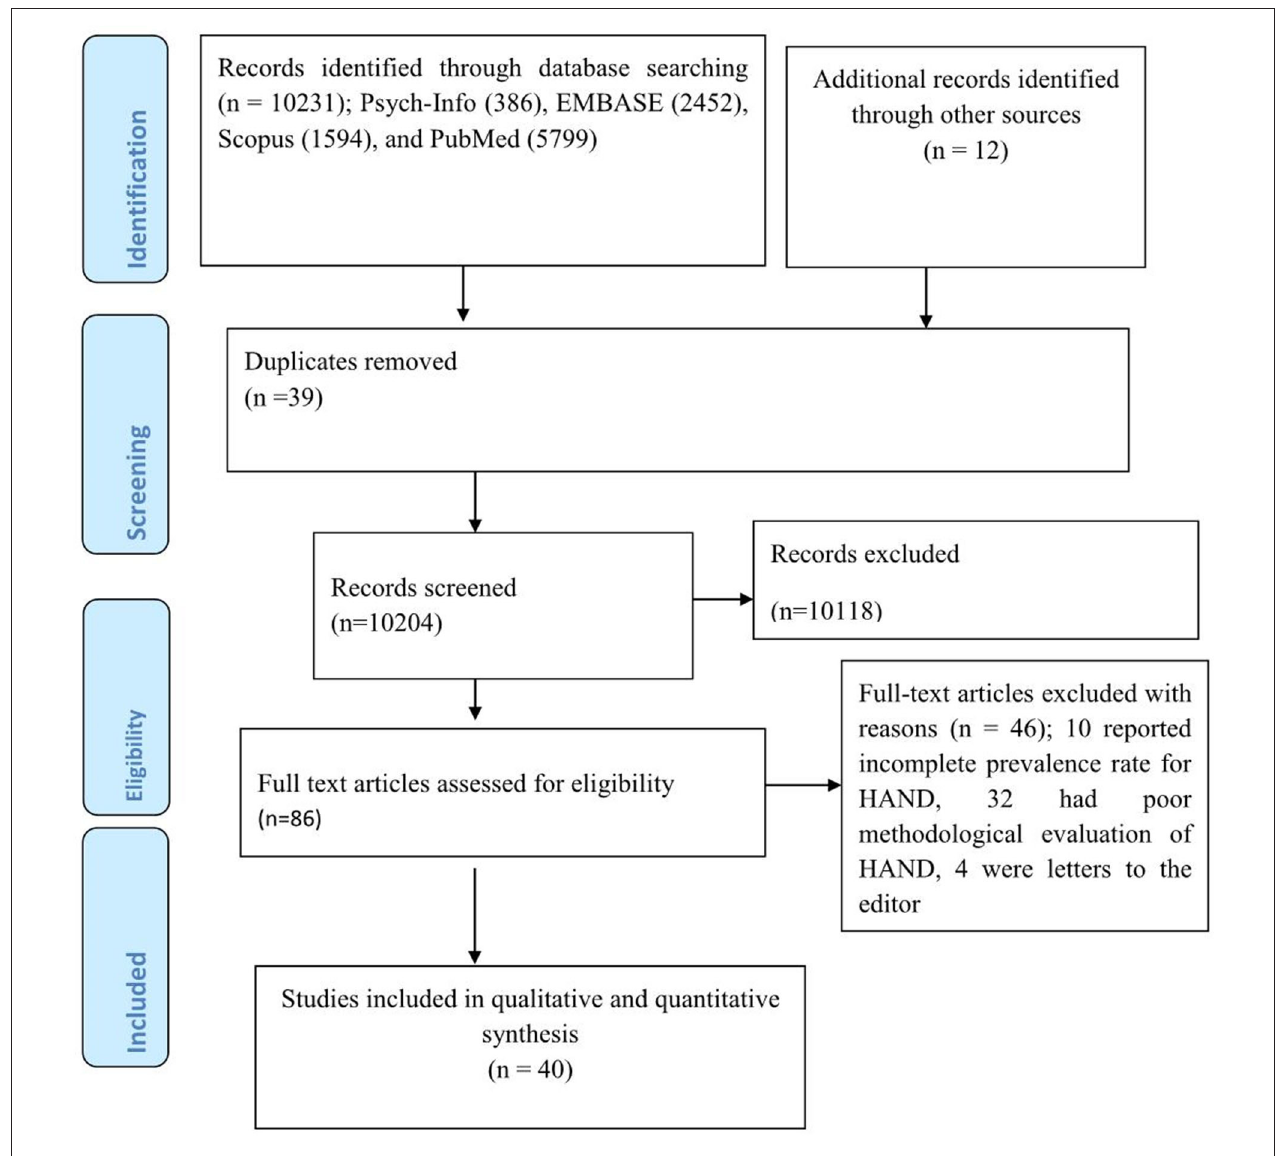
FIGURE 1 | PRISMA flow chart for the review search